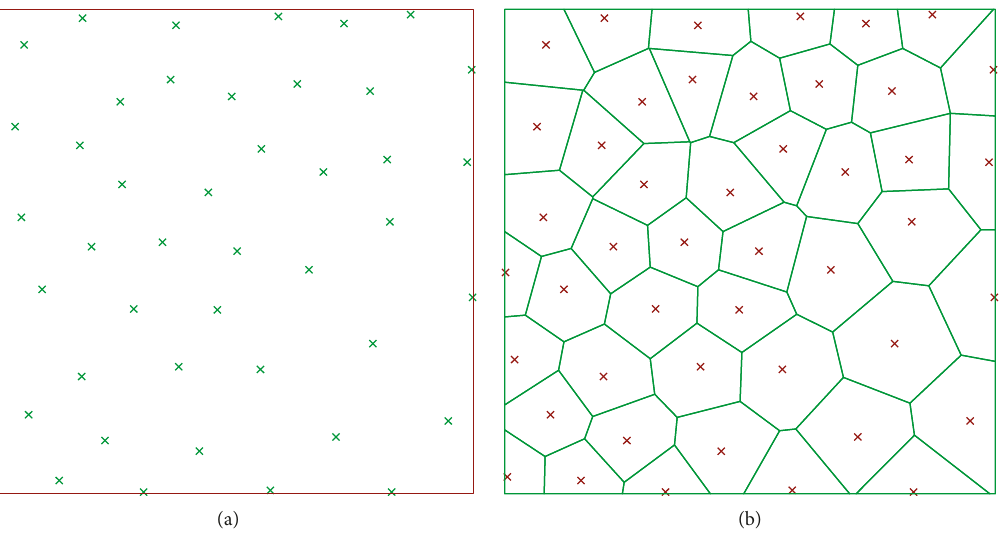
Figure 3: Random cellular material in 2D: (a) seed and (b) region partitioning.